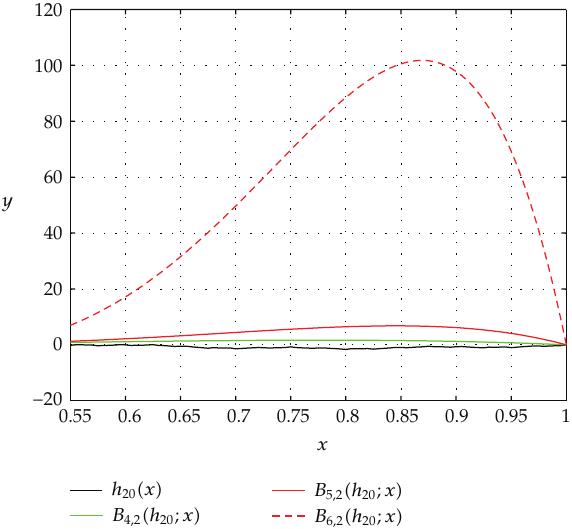
Figure 5: Graphs of y (cid:6) h 20 (cid:2) x (cid:3) and y (cid:6) B n, 2 (cid:2) f ; x (cid:3) , n (cid:6) 4 , 5 ,